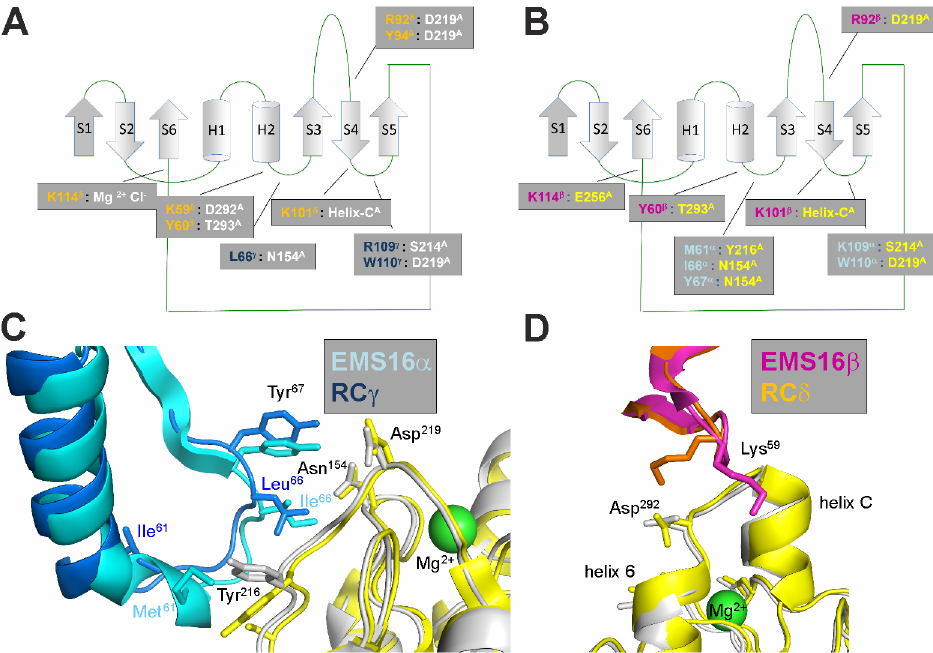
Fig 8. A comparison of the RC γδ - α 2Aand EMS16 αβ - α 2Abinding interfaces. ( A,B )The C-typelectin- relatedprotein(CLRP)folds of both homologous subunitsof RC γδ ( A )andEMS16 αβ ( B )are highlyhomologous withmany of the residuesinvolvedin the α 2Abindingconserved between the 2 proteins.Theseresidueshave beenmappedonto the CLRPfold andcolorcodedfor rhodocetin(RC)(blueandorangefor the γ and δ subunits, respectively, in [ A ])andfor EMS16(lightblue andmagentafor the α and β subunits, respectively,in [ B ]).The partnering residuesof the α 2Adomaincontactedby RC andEMS16are colorcodedin whiteandyellow, respectively. The samecolorcodingschemeis usedthroughout the figure.( C,D )A superposition of the key residuesfrom RC γ /EMS16 α at the loop2 bindingsite ( C )andof RC δ /EMS16 β at the helix C bindingsite ( D ), respectively, on α 2A.The contact sites are largelyconservedbetweenRC γδ /EMS16 αβ and α 2A,althoughthere are a coupleof notabledifferences. For example,L66of RC γ contacts Y216of α 2Ain additionto the N154of loop1 observedfor the correspondingI66 of EMS16 α .In addition,K59 of RC δ forms a salt bridgeto D292of α 2A,whereas,in EMS β ,the correspondingK59 pointstowardshelix C.